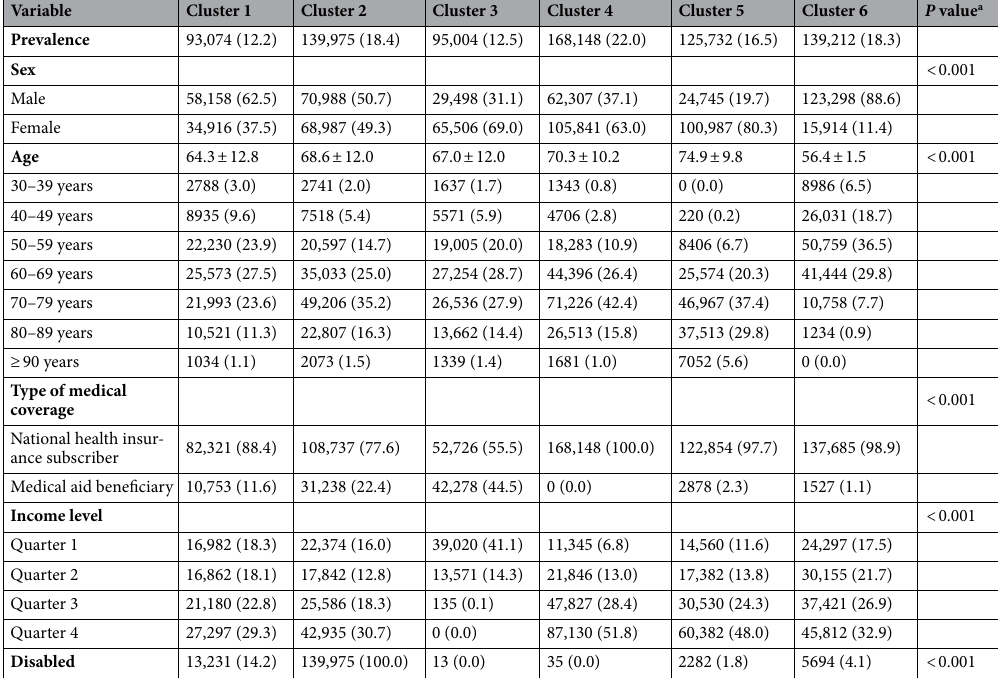
Table 2. Sociodemographic patterns of patients with polypharmacy using K-means clustering (n = 761,145). Categorical variables were evaluated using the chi-square test as frequencies (percentages), and continuous variables by t-test as mean values with standard deviation. a P values < 0.05 were statistically